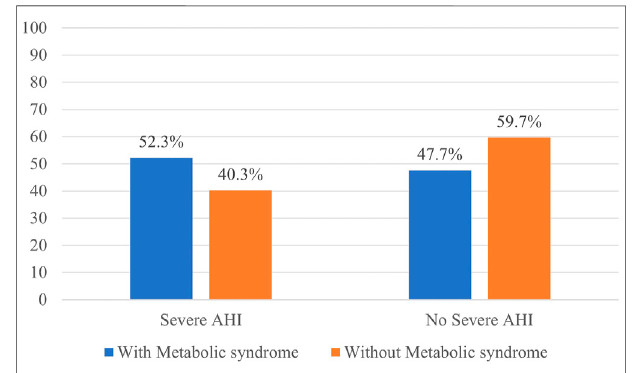
FIGURE 1 | Distribution of the patients with and without metabolic syndrome according to OSA severity.